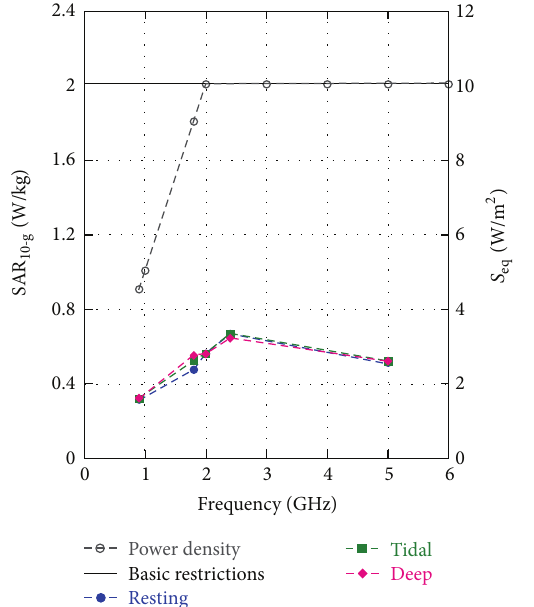
Figure6:SAR 10 inthelungsfortheRS,TB,andDBmodelsandthe -g power density reference level allowed for general public in ICNIRP and IEEE 2005